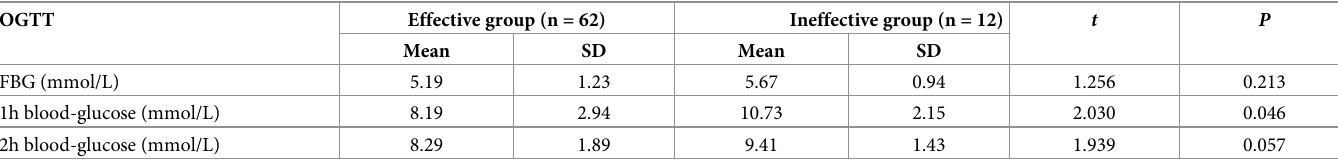
FBG: Fasting blood